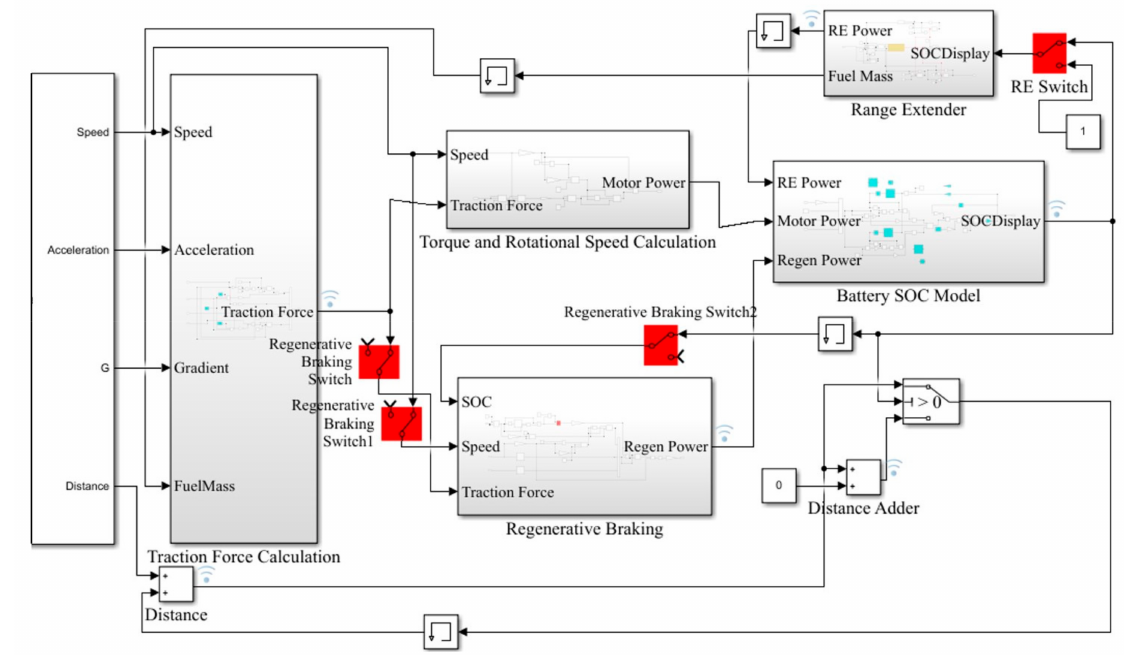
Figure 4. Simulink model for the